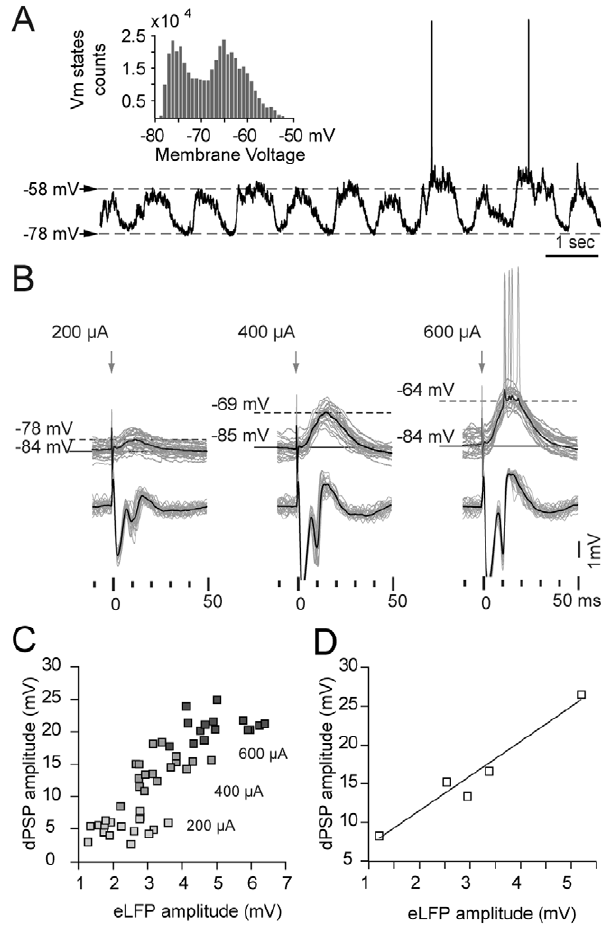
Figure 2. Striatal field responses are related to dPSPs in medium spiny neurons. A. As in rats, the membrane potential of mouse MSNs alternates between up and down states. The histogram (1 mV bin) shows a biphasic distribution of Vm values corresponding to 20 seconds of the illustrated intracellular recording. B. Simultaneous intracellular ( above ) and local field ( below ) recordings obtained with separate glass microelectrodes after stimulating the prelimbic cortex with different current intensities. Individual traces are displayed in gray, averages in black. The through in the local field response coincides temporally with the peak of the dPSP. C. The amplitudes of simultaneously recorded striatal dPSPs and evoked local field potentials (eLFP) increase in parallel with increasing stimulation intensities. Data corresponds to one simultaneously recorded pair stimulated at 200, 400 and 600 m A. D. Correlation between eLFP and dPSP amplitude evoked by prelimbic cortex stimulation at 400 m A in five different experiments (n=5, r 2 =0.94, p ,